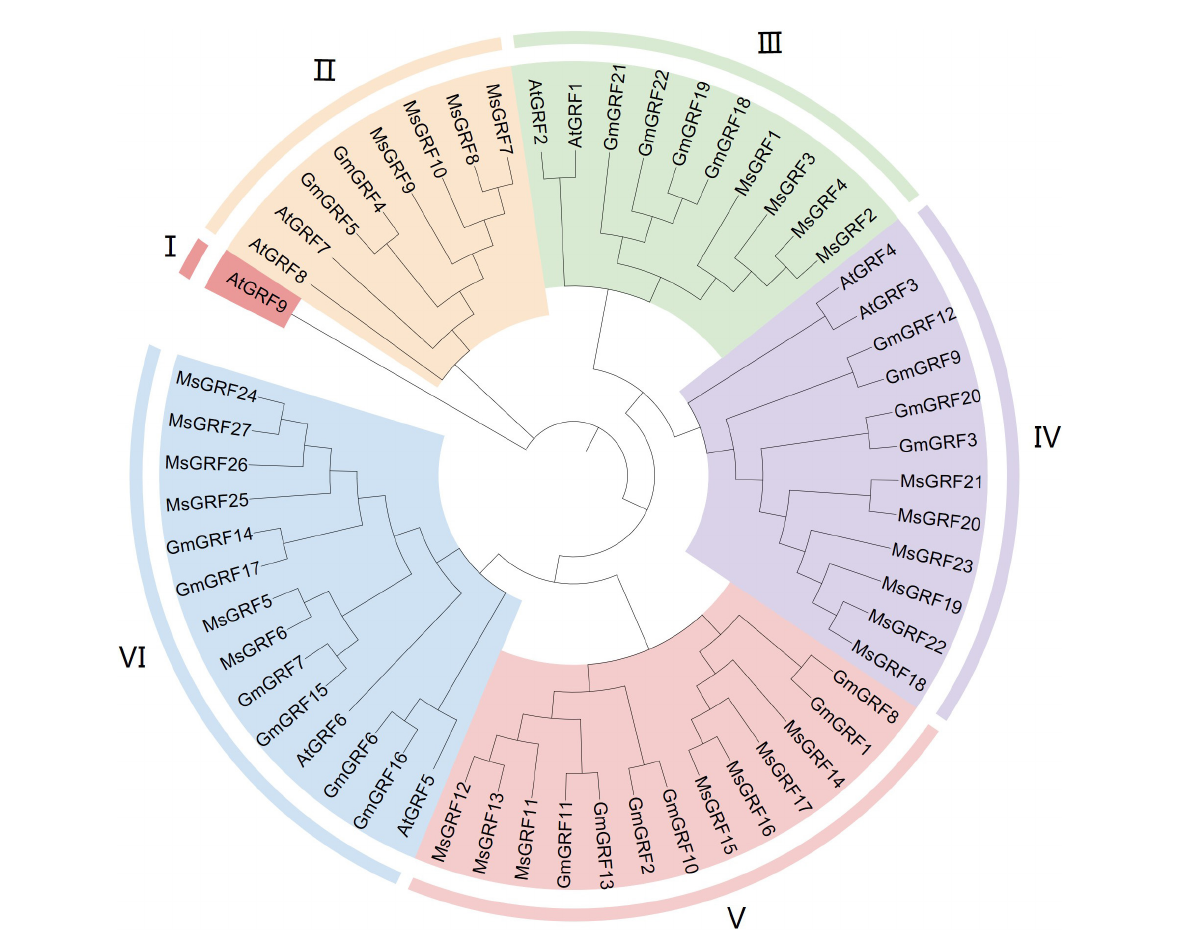
FIGURE1 Phylogenetic analysis of growth-regulating factors (GRFs) from Medicago sativa L. (Ms), Glycine max (Gm) and Arabidopsis thaliana (At). MEGA 7.0 software was employed to construct a neighbor-joining phylogenetic tree with 1,000 bootstrap replications. Subgroups are highlighted with different